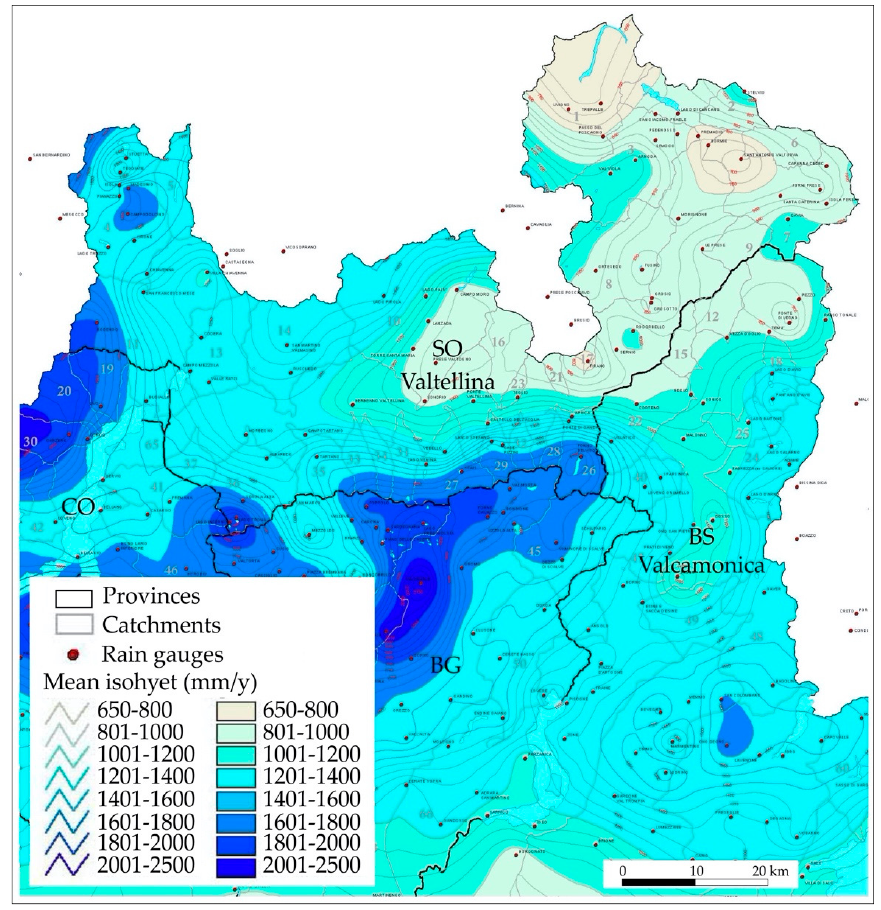
Figure 3. Map of the mean annual precipitation (MAP) in the 1891–1990 period [92] in the alpine region of Lombardy: BG, Bergamo Province; BS, Brescia Province (Valcamonica); CO, Como Province; SO, Sondrio Province (Valtellina).